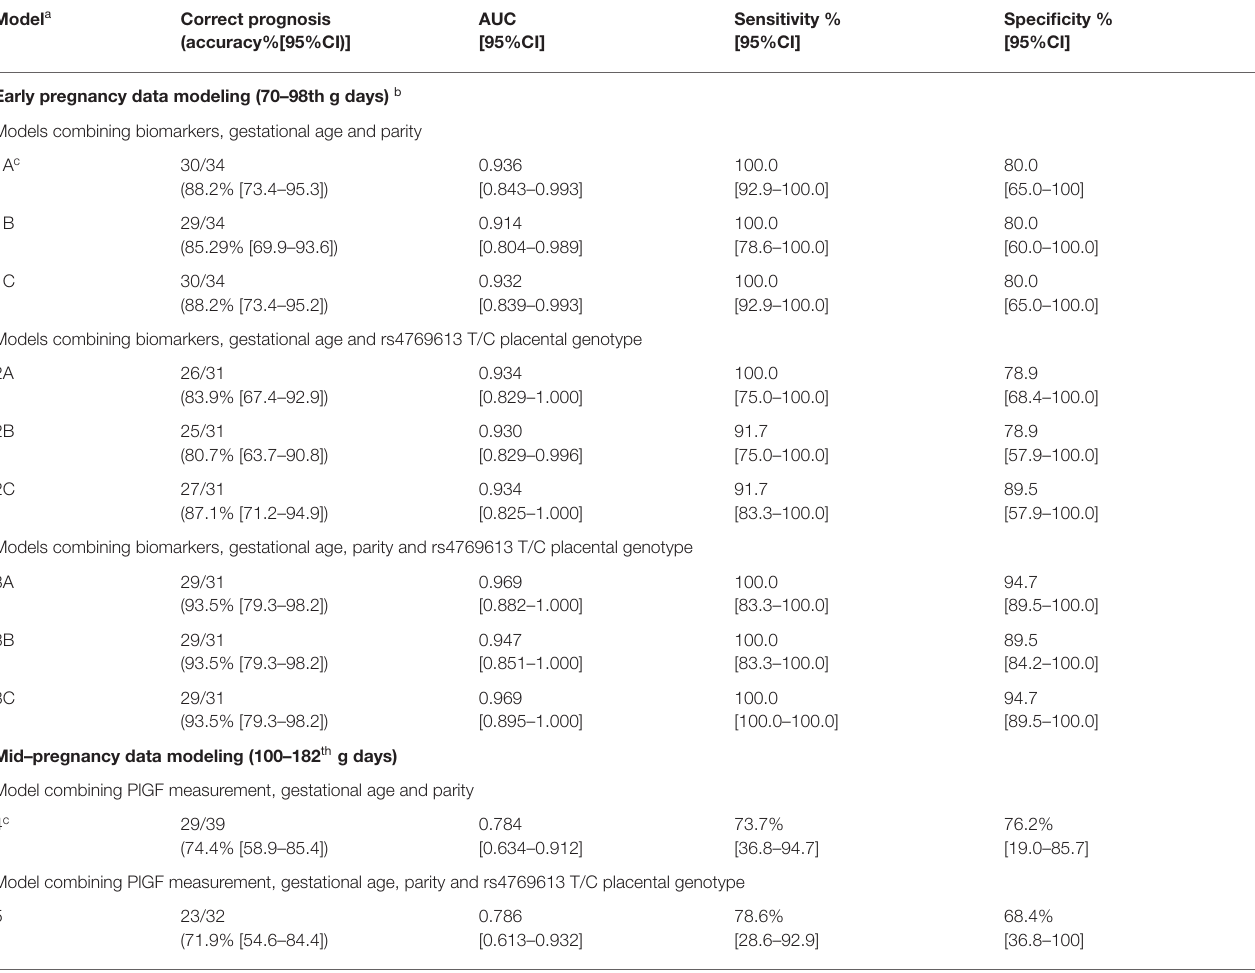
TABLE 5 | Characteristics of PE prediction